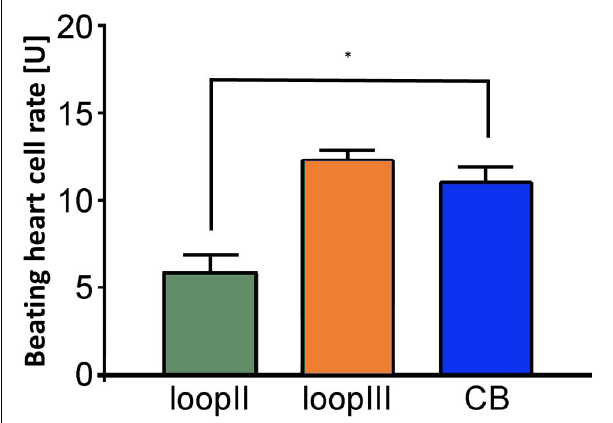
FIGURE 3 | Epitope mapping of the inhibitory anti– β 2 -AAb in patients with PEX syndrome revealed that inhibitory anti– β 2 -AAb targets extracellular loop III. Peptides of the β 2 -adrenergic receptor extracellular loops II and III were used for epitope mapping of the inhibitory anti– β 2 -AAb in patients with PEX syndrome in the presence of clenbuterol (Cb): peptides against the third loop did block the binding site of the inhibitory anti– β 2-AAb. Consequently, additional application of Cb did show an increase in the beating rate (orange); peptides against the second loop did not block the binding site of the inhibitory anti– β 2-AAb. Consequently, the inhibitory nature of the inhibitory anti– β 2-AAb reduced significantly the Cb effect ( ∗ p = 0.001, green); application of clenbuterol alone (control, blue); 1 unit (U) reflects 4 beats/min; mean ± standard deviation (SD).